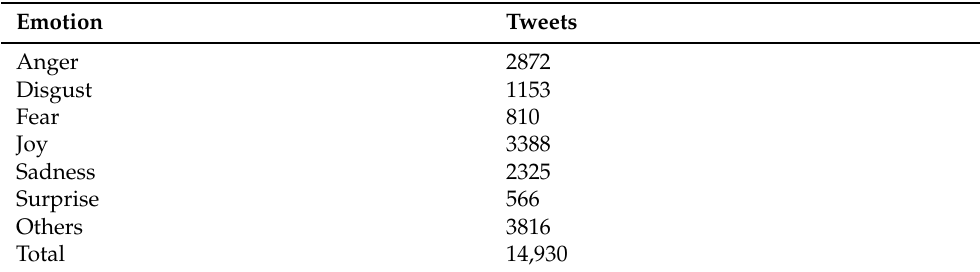
Table 2. Number of tweets per category in the expanded training corpus (EmoEvent +